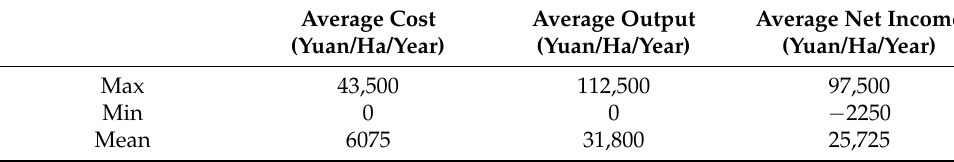
Table 4. Basic situation of farmers’